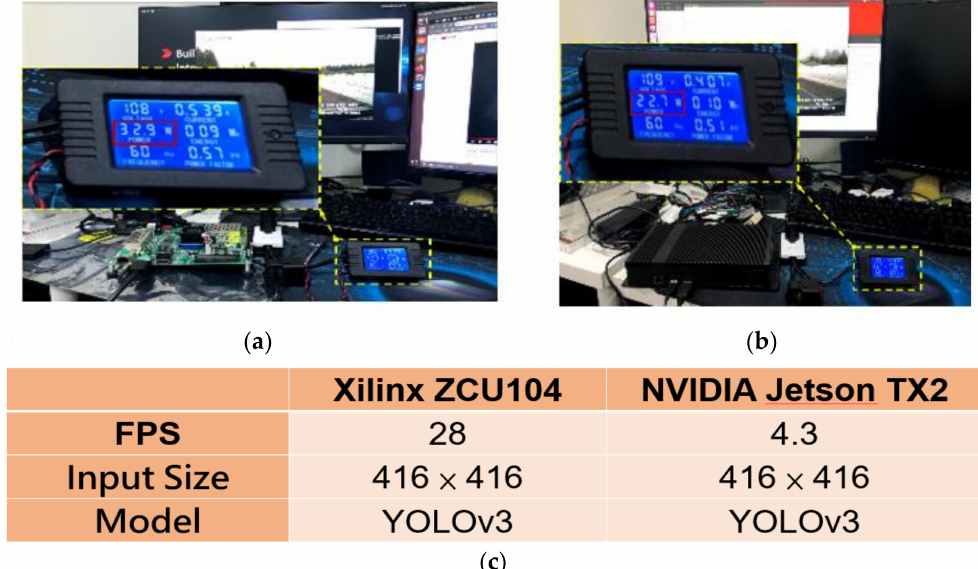
Figure 5. Implementation of embedded system for YOLOv3-based pavement defect detection systems. ( a ) Xilinx ZCU104 platform; ( b ) Nvidia TX2 platform; ( c ) quantitative performance